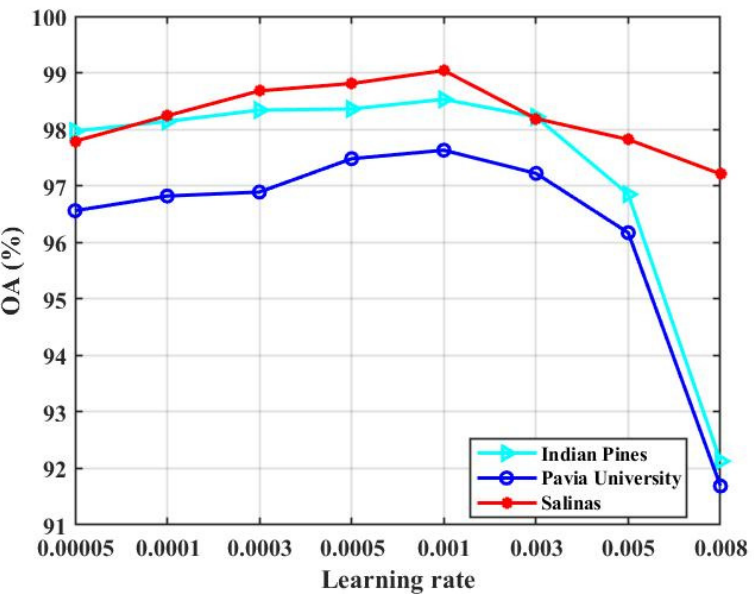
Figure 17. The classification result (OA) of our presented TSSFAN with different learning rates for all three HSI datasets. three HSI